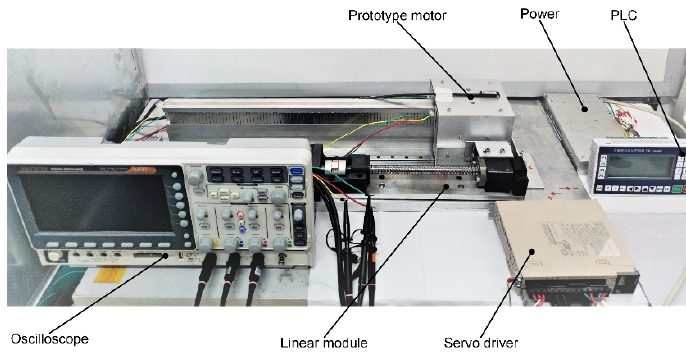
Figure 15. The no-load back EMF test platform of the prototype.